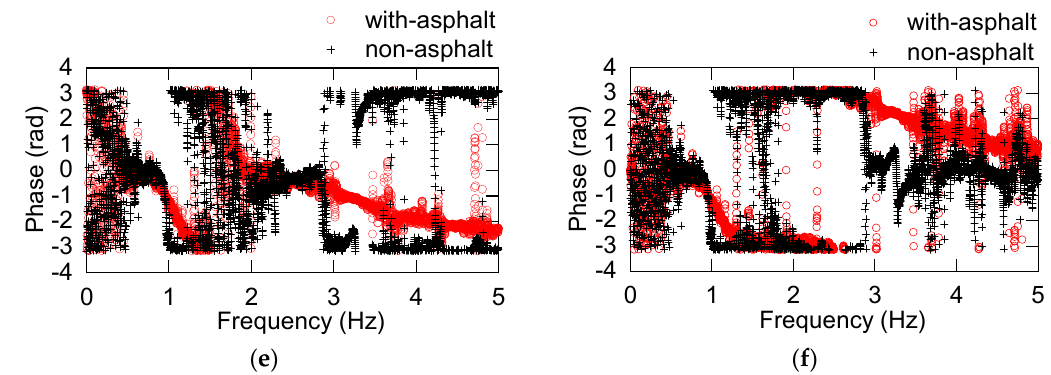
Figure 15. Acceleration responses, Frequency Response Function and Phase spectra of non-asphalt and with-asphalt tests: ( a ) 1st floor acceleration responses of test condition Nos. 1, 13; ( b ) top floor acceleration responses of test condition Nos. 1, 13; ( c ) 1st floor FRF of test condition Nos. 1, 13; ( d ) top floor FRF of test condition Nos. 1, 13; ( e ) 1st floor phase of test condition Nos. 1, 13; ( f ) top floor phase